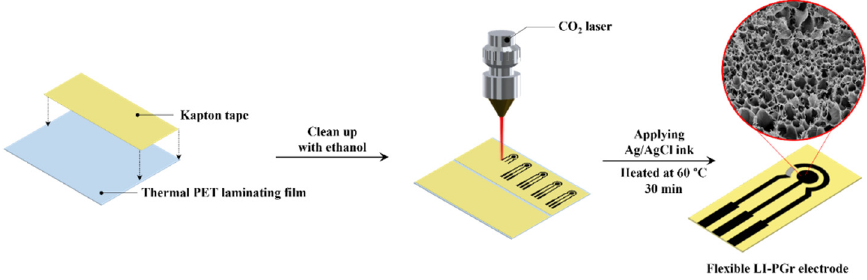
Figure 1. Schematic representation of the laser-induced porous graphene electrode fabrication.